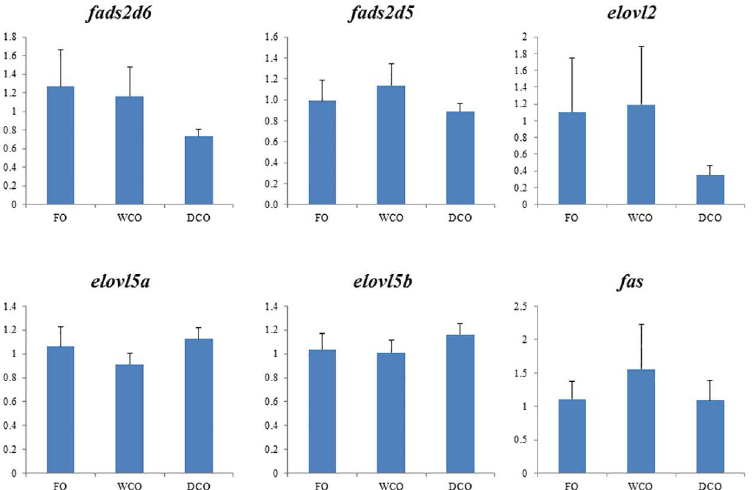
Fig 10. Expression of genes of the LC-PUFA biosynthesis pathway in hindgut of Atlantic salmon as determined by qPCR. Results are normalizedexpression ratios (means ± SEM; n = 6). FO, fish oil diet; WCO, wild type camelinaoil diet; DCO, EPA+DHA camelinaoil diet. fads2d6 ,delta-6 fatty acyl desaturase; fads2d5 ,delta-5 fatty acyl desaturase; elovl2 , fatty acyl elongase2; elovl5a ,fatty acyl elongase 5 isoform a; elovl5b ,fatty acyl elongase 5 isoform b; fas , fatty acid synthase. Different superscript letters denote differences amongtreatments identifiedby one-wayANOVA.